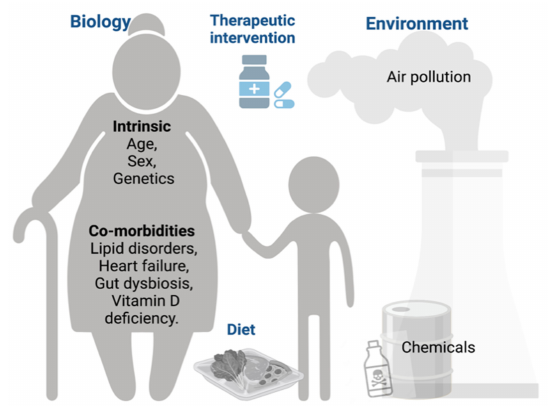
Figure 2. Factors modulating the clinical outcomes of COVID-19 investigated in this study, being representative of different categories: intrinsic (age, sex, and genetic factors), co-morbidities (dyslipi- demia, obesity, pre-existing heart failure, and gut dysbiosis), lifestyle-related (vitamin D deficiency and diet). and environmental (air pollution and exposure to chemicals). Created with Biorender.com